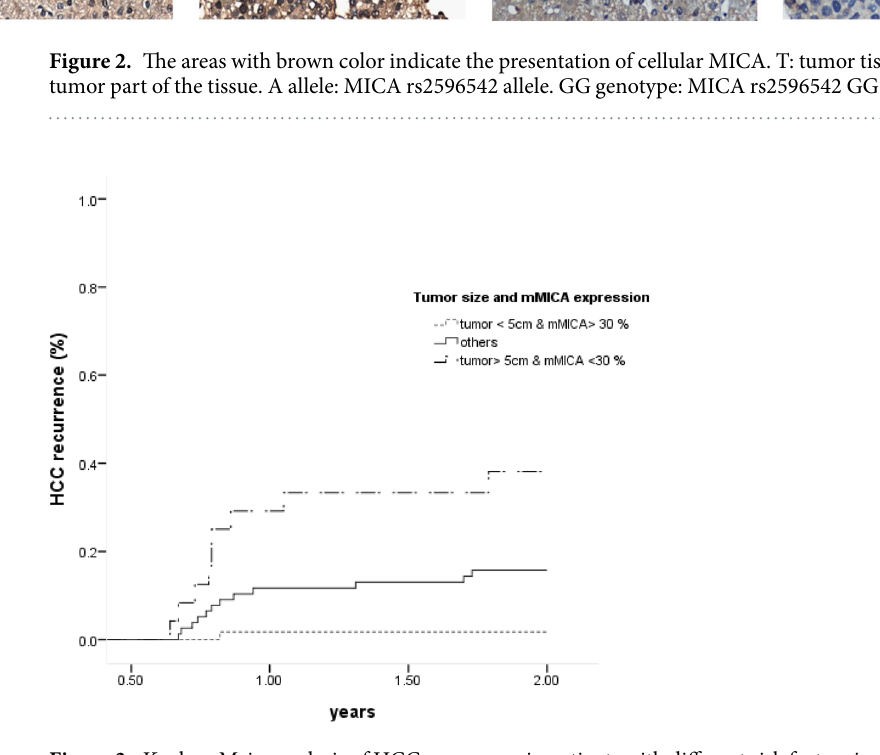
Figure 3. Kaplan–Meier analysis of HCC recurrence in patients with different risk factors including tumor size and cellular MICA expression. MICA: MHC class I chain-related A